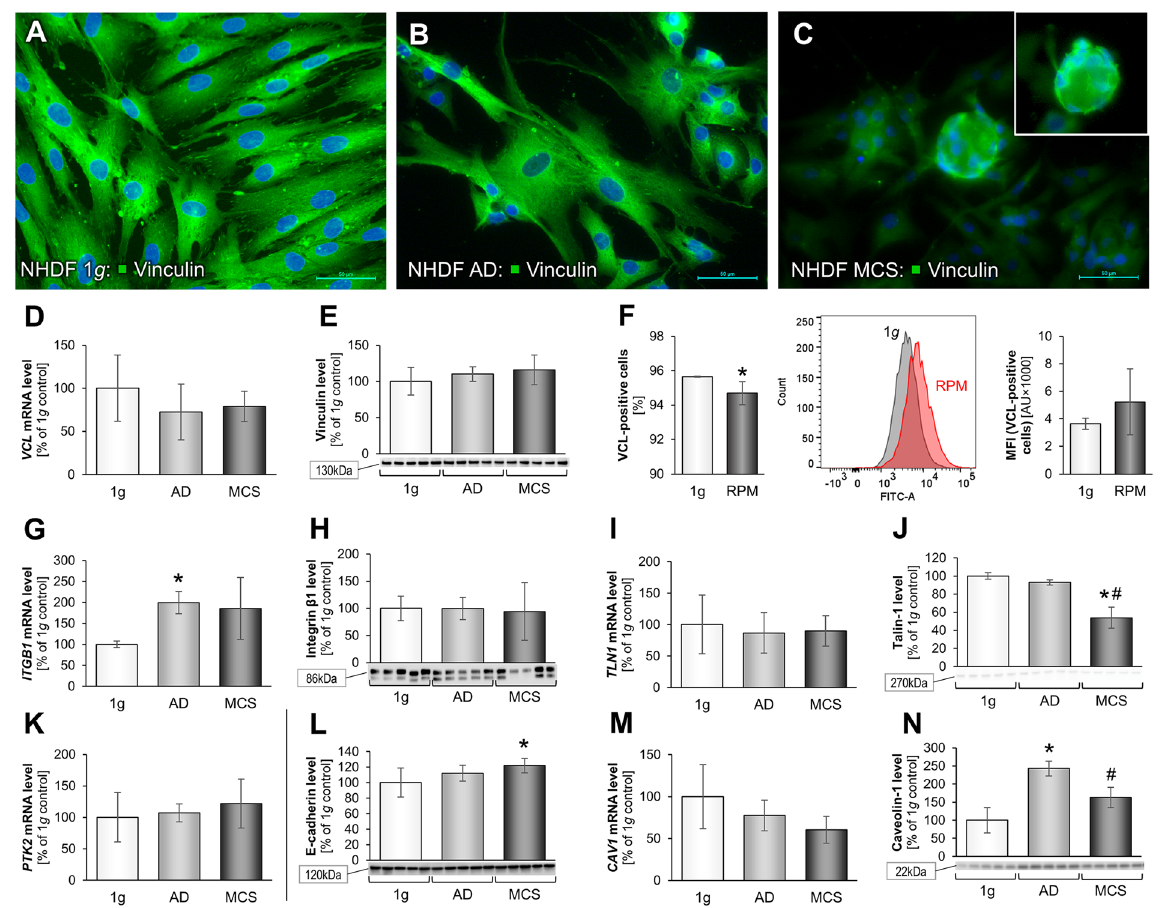
Figure 4. Alterations in focal adhesion-associated genes and proteins after a 3-day s- µ g -exposure: Immunofluorescence images of 1 g -control cells, RPM-AD and RPM-MCS of vinculin ( A – C ). Transcriptional and translational vinculin analysis: Quantitative gene expression levels of VCL ( D ), intracellular vinculin levels ( E ) and flow cytometric analysis of vinculin-labeled cells ( F ). Transcriptional and translational integrin- β 1 analysis: Quantitative gene expression levels of ITGB1 ( G ) and intracellular integrin- β 1 levels ( H ). Transcriptional and translational talin analysis: Quantitative gene expression levels of TLN1 ( I ) and intracellular talin-1 levels ( J ). Quantitative gene expression levels of FAK1 / PTK2 ( K ). Intracellular E-cadherin levels ( L ). Transcriptional and translational caveolin-1 analysis: Quantitative gene expression levels of CAV1 ( M ) and intracellular caveolin-1 levels ( N ). Full-length blots of cropped Western blot images are presented in Supplementary Fig. S3. * p < 0.05 1 g vs. RPM; # p < 0.05 AD vs. MCS. Scale bars: 50 µ